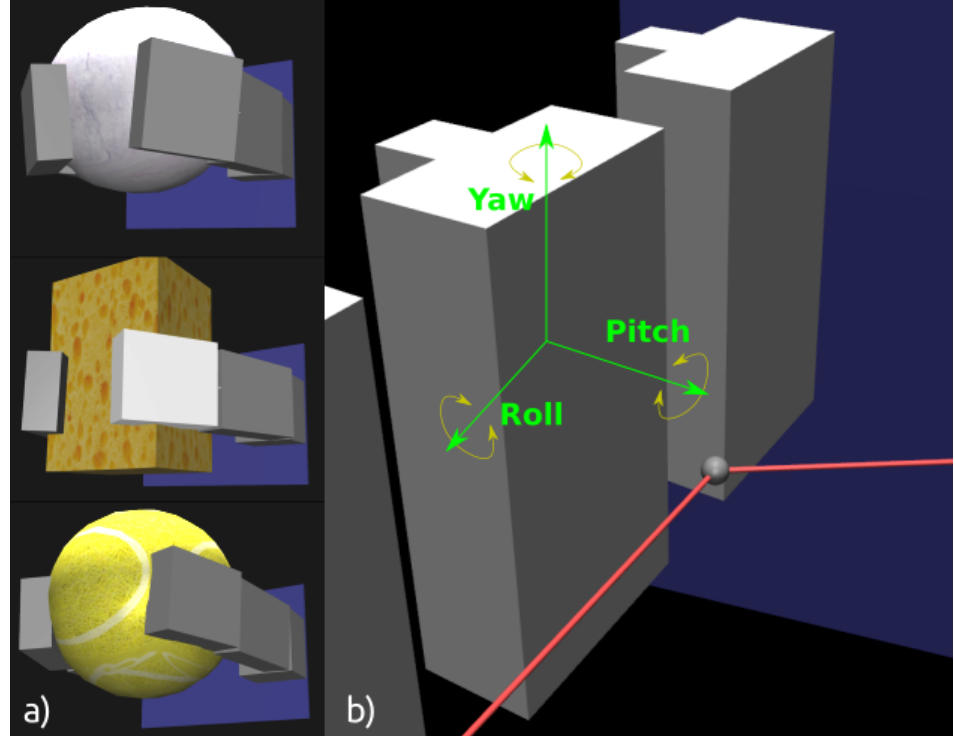
Figure 4. Soft-robotic gripper in the MuJoCo environment: ( a ) the gripper squeezes and releases objects in three shapes—a ball, a box and a cylinder, all with a variable stiffness parameter; ( b ) each geometrical block of each finger is connected to others by three hinges. In this setup, we can easily adjust the ranges of each joint in a roll, pitch and yaw